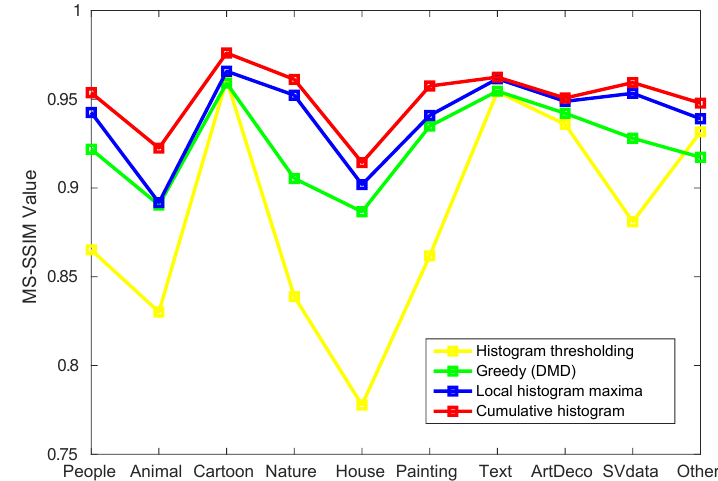
Figure 3. Average MS-SSIM scores for four layer selection methods (30 layers selected) for images in ten different classes. The cumulative histogram method performs the best and is hence used in CDMD. Table 1. The benchmark of 100 images (available at [40]) used throughout this work for testing